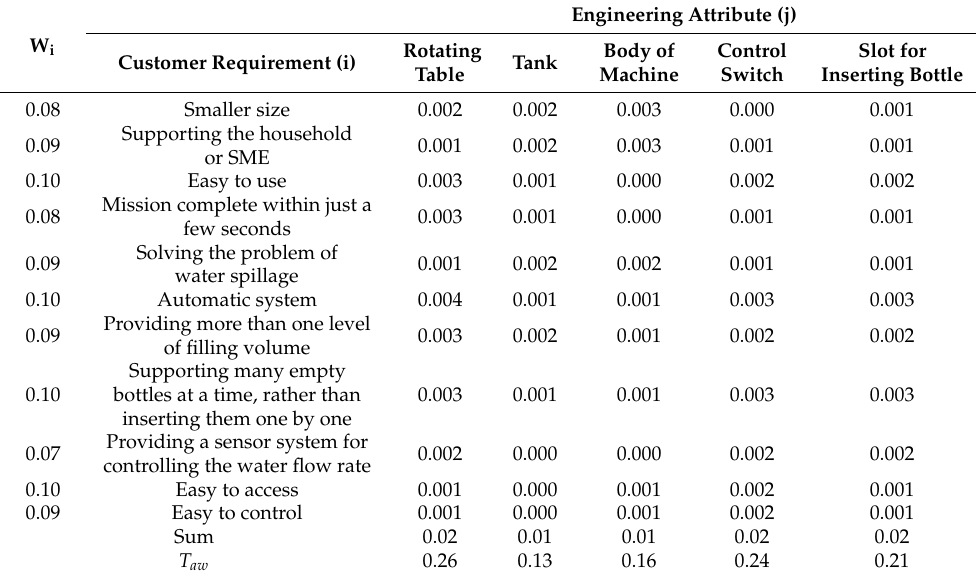
Table 6. The importance weight of engineering